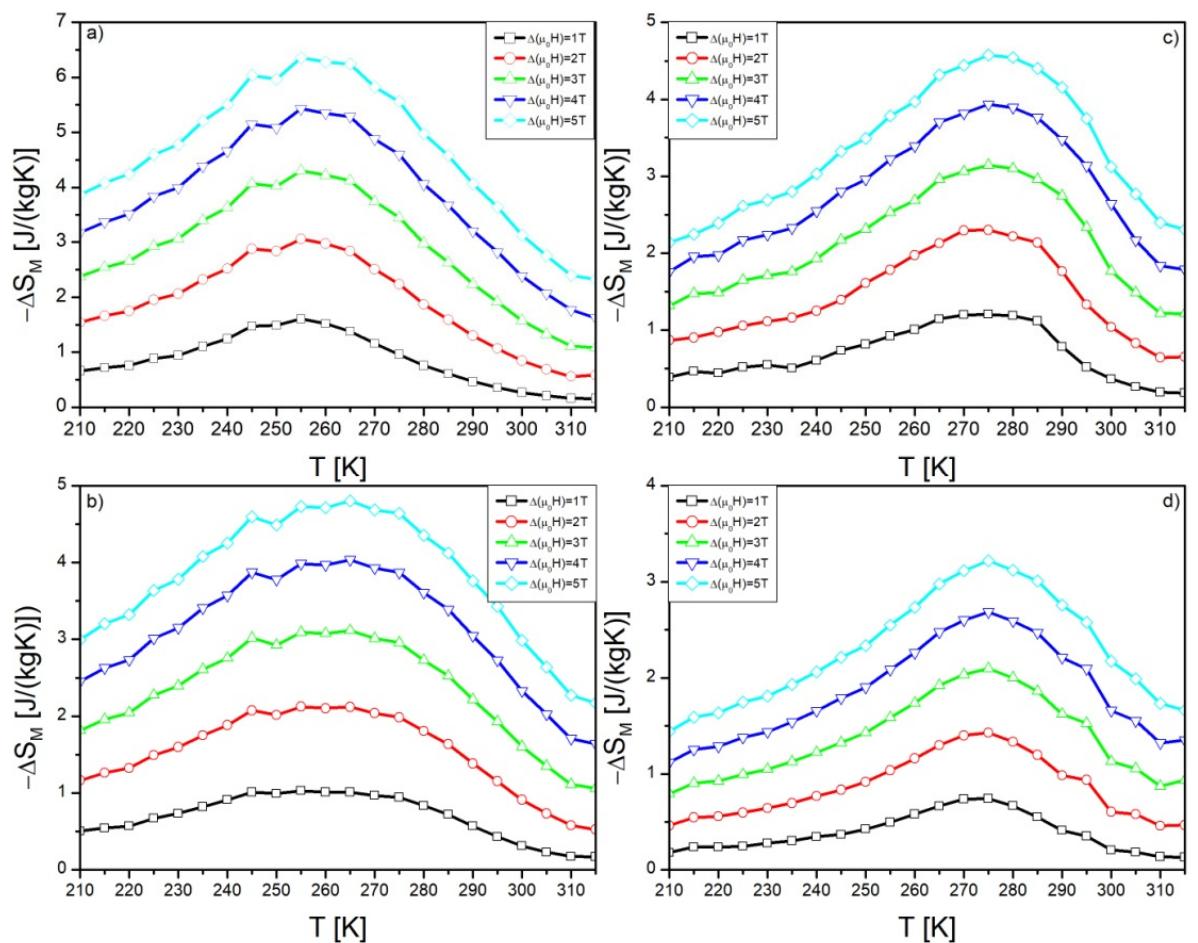
Figure 5. Temperature dependences of magnetic entropy change ∆ S M calculated for: Gd 95 Pb 5 ( a